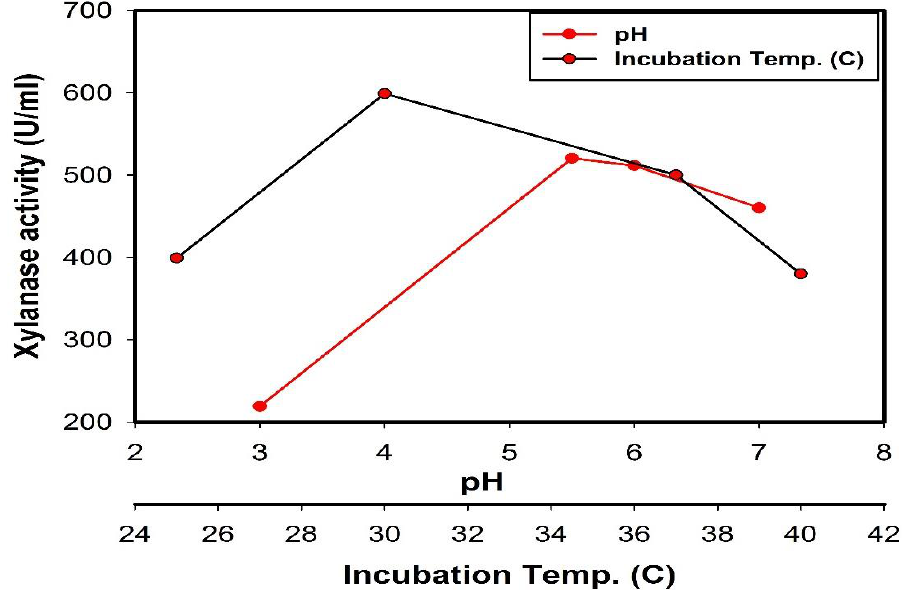
Figure 4. Relation of different incubation temperatures (°C) and pH values to xylanase production by Trichoderma harzianum kj831197.1.